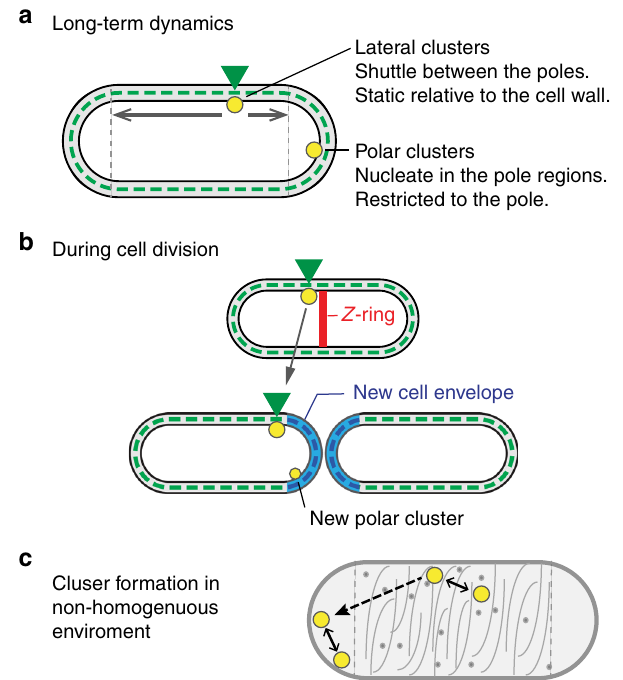
Fig. 7 Positioning of receptor clusters. a The long-term positional dynamics of clusters. Clusters that nucleate in pole regions remain polar. Clusters that nucleate in the lateral region remain static relative to their local cell- wall matrix (green arrowhead) for many generations, at least in the direction of the long axis of the cell, and thus effectively shuttle between the cell poles. b Mid-cell lateral clusters avoid becoming polar during cell division by remaining static relative to their original cell-wall environment and avoid translocation to the new pole region (blue). c To the extent that the cell envelope physiology affects the local environment of the receptors, it might be expected that variations are created between the pole and lateral regions. Such variations can potentially affect the basic ‘ diffusion and capture ’ clustering dynamics by affecting the local mobility and clustering ef fi ciency of receptor complexes and, thus, possibly promote polar